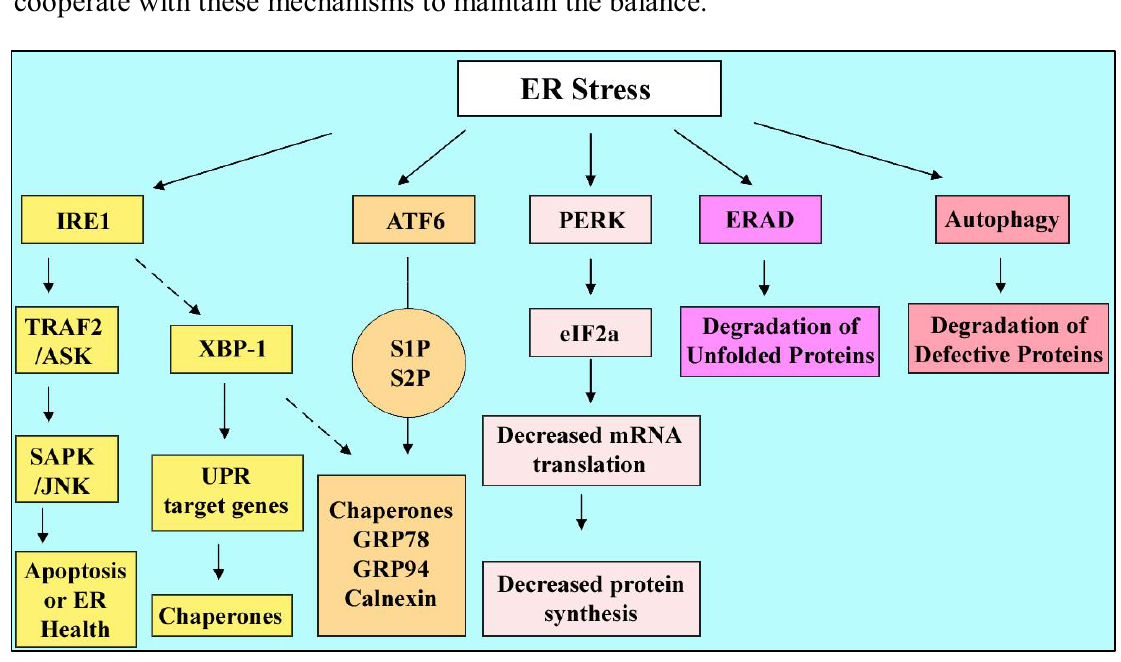
Figure 6. ER stress responses. Different signaling pathways are involved which promote production of chaperones to fold back the unfolded proteins ( IRE1, ATF6) or reduction of protein synthesis (PERK) to decrease the work load on ER. ERAD and autophagy also cooperate with these mechanisms to maintain the